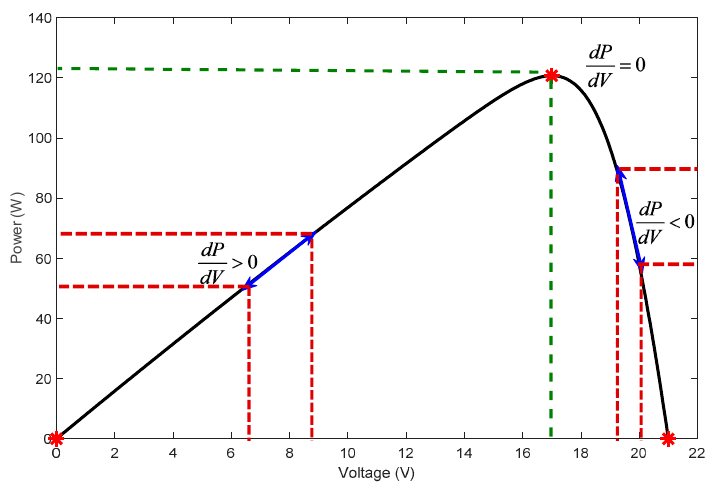
Figure 5. Operating point according to the sign of dP/dV.